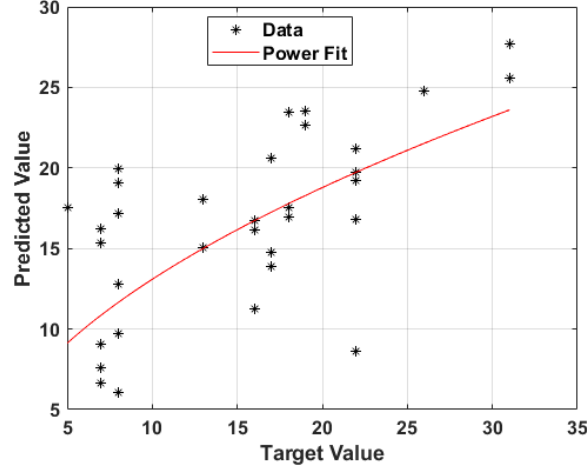
Figure 11. System failure plot of target vs. predicted value for MLR Model 1 training.